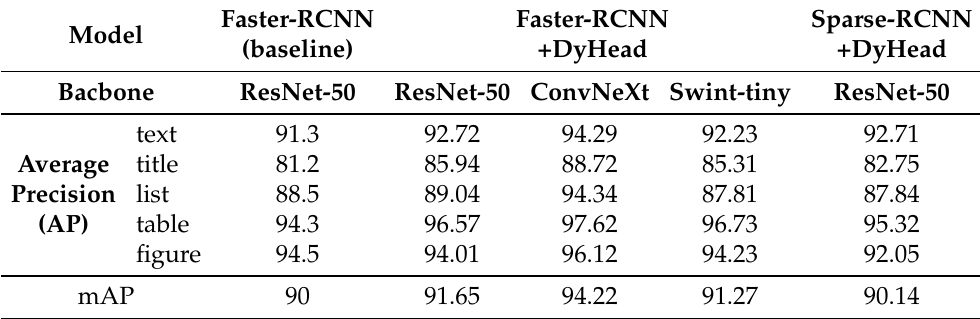
Table 4. Performance evaluations of PublayNet using Faster-RCNN with different backbones. Results with Sparse-RCNN using ResNet-50 backbone are also presented. For Faster-RCNN+ResNet-50, the attention mechanism contributes a slight improvement. However, the model benefits largely from the ConvNeXt backbone complemented with the attention mechanism to improve the feature saliency.